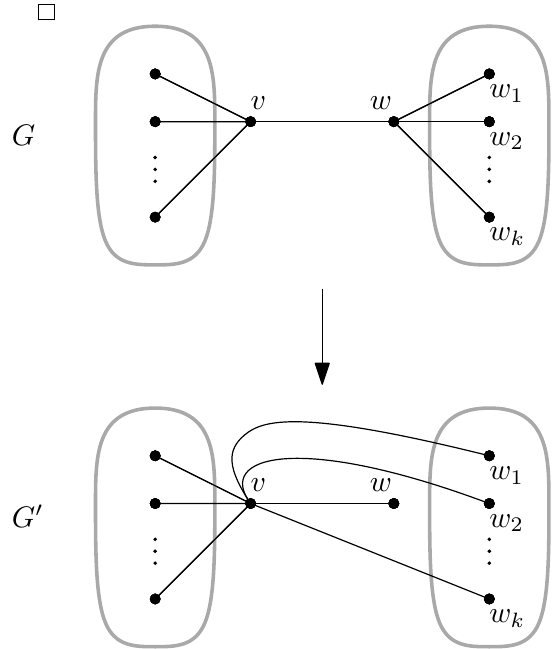
Figure 2. Transformation 1 used in the proof of Lemma 4, when the edge vw does not lie on a